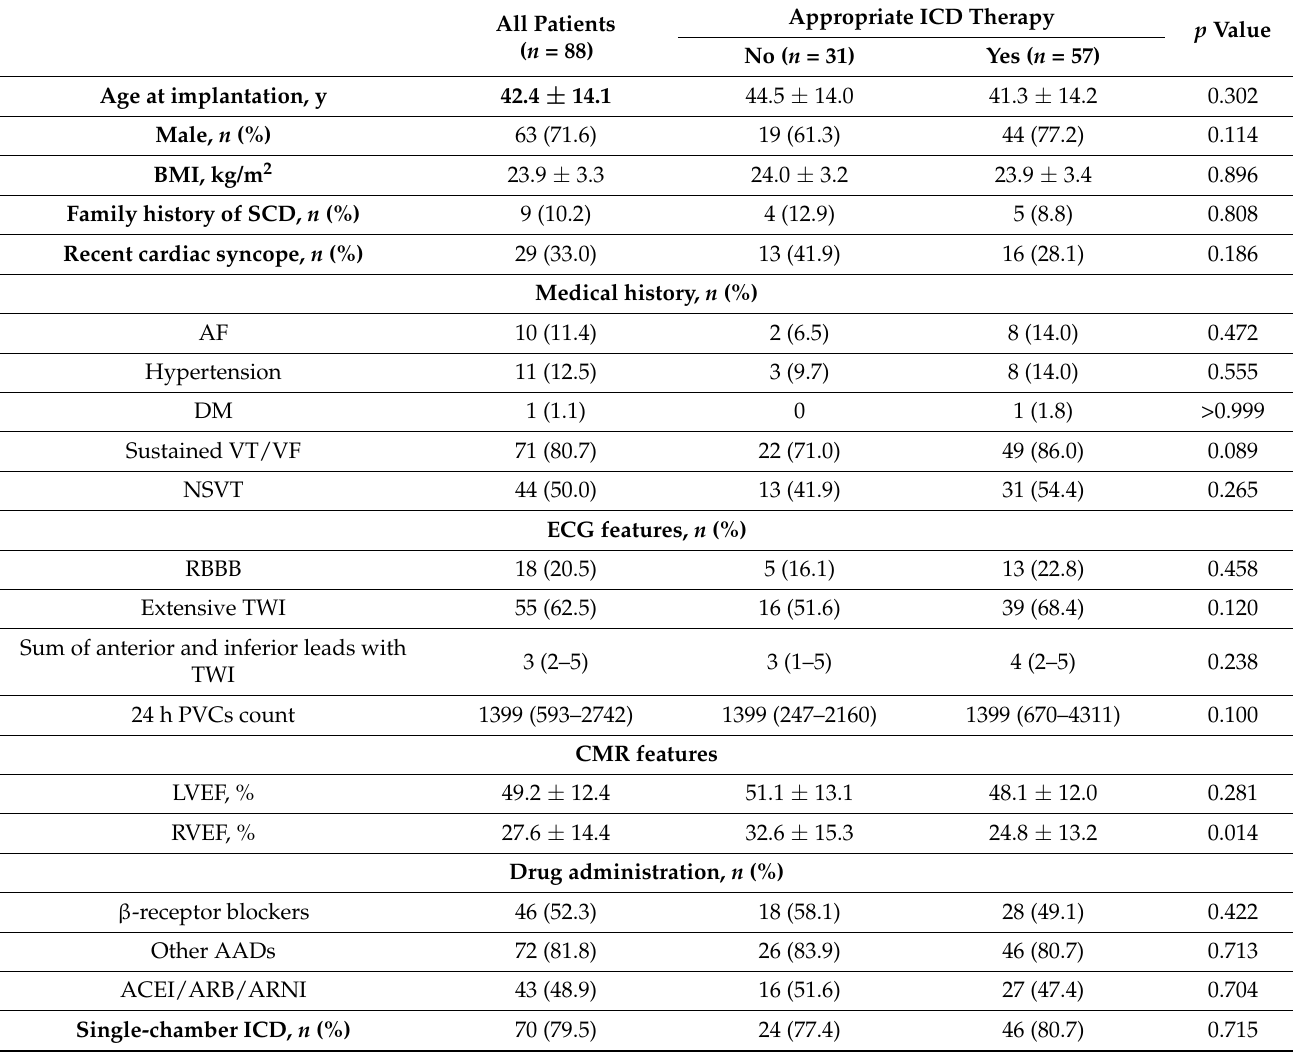
Table 1. Baseline clinical characteristics between patients with and without appropriate ICD